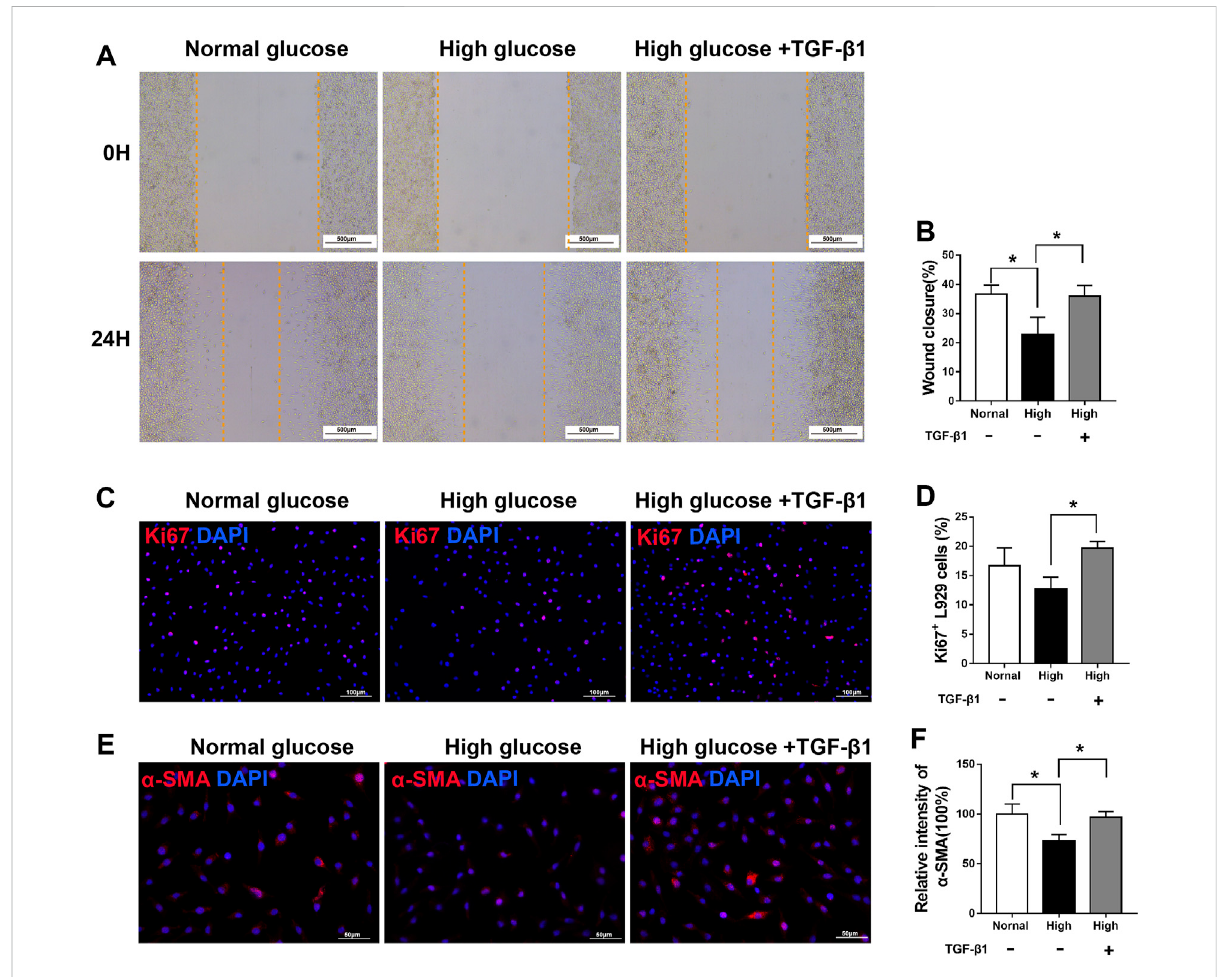
FIGURE 10 TGF- β 1 treatment rescues the viability of fi broblasts under high glucose (A,B) A scratch assay of L929 fi broblasts cultured in normal glucose (5.5 mM), high glucose (50 mM)or high glucose added with TGF- β 1 (10 ng/ml) conditions. Representative immuno fl uorescence analyses ofKi67 (C) and α -SMA (E) , and the numbers of Ki67 + cells (D) and intensity of α -SMA immunoreactivity (F) , in L929 fi broblasts cultured and treated as described for (A,B) . Data are presented as mean ± SD of three independent experiments, ** p < .01 and* p < .05, one-way ANOVA, Tukey ’ s post hoc